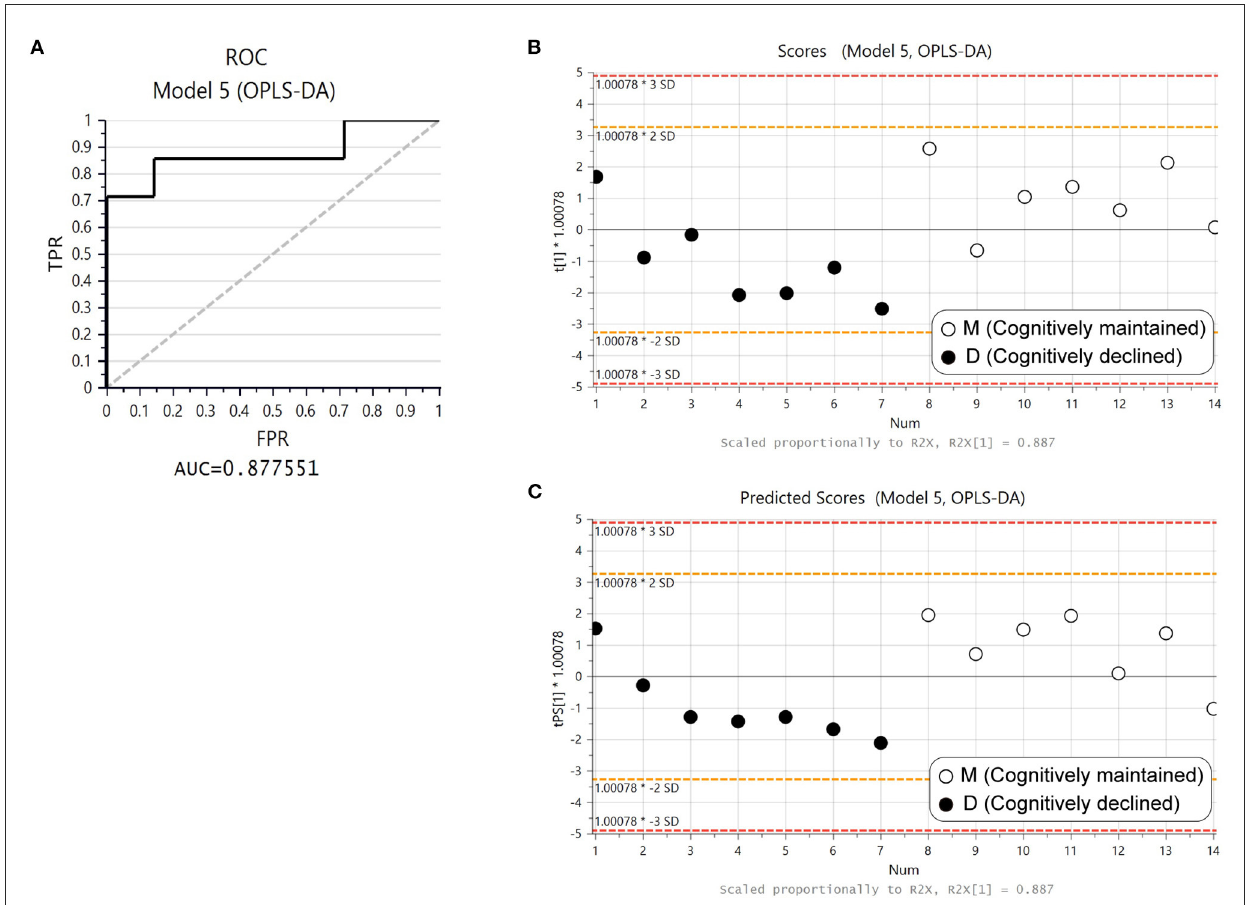
FIGURE3 Predictive performance of ORM1, ORM2, and SERPINA3 with OPLS-DA. (A) Receiver operating curve (ROC) from the OPLS-DA model created with ORM1, ORM2, and SERPINA3 using baseline data (Model 5). (B) Score plot of Model 5. Solid circles: Group D1, open circles: Group M1. (C) Plot of predicted scores using follow-up data. Solid circles: Group D5, open circles: Group